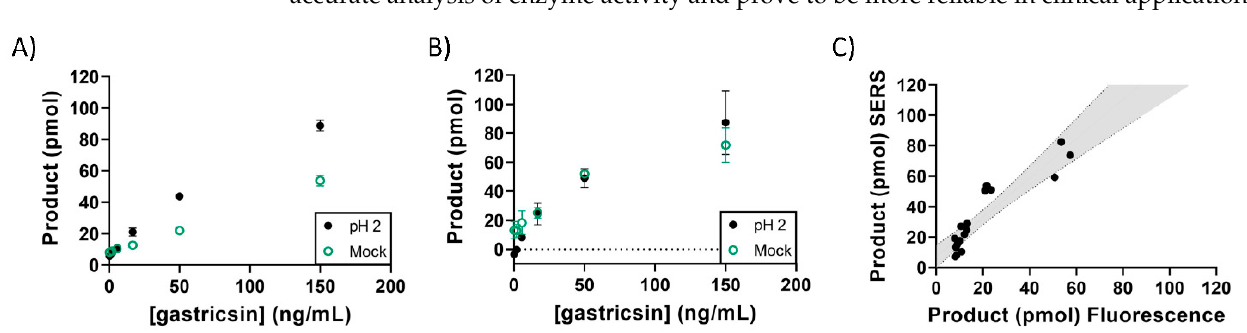
Figure 4. Gastricsin activity assay in samples comprised of a mock mucus matrix containing pan- creatic enzymes with a viscosity of 1.5 cP to simulate a pancreatic cyst fluid sample. ( A ) Measured product formation calculated from fluorescence measurement at each concentration of gastricsin as indicated on the x-axis. ( B ) Measured product formation calculated from SERS measurement at each concentration of gastricsin as indicated on the x-axis. The samples are the exact same from panel ( A ). Error bars represent the standard deviation of triplicate measurements. ( C ) Correlation of prod- uct formation between SERS and fluorescence measurements from paired reaction samples. The grey area is the 95% confidence interval from a linear regression analysis with a slope = 1.293 and R 2 = 0.836.